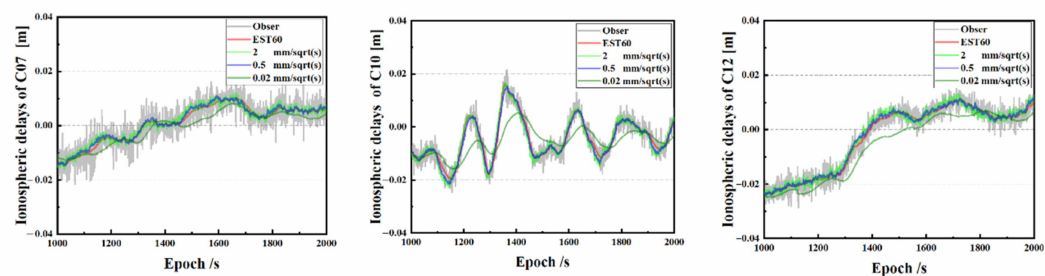
Figure 7. The estimated ambiguities of the float solutions with the ionospheric delays PSD of EST60, 2 mm/ √ s . and 0.02 mm/